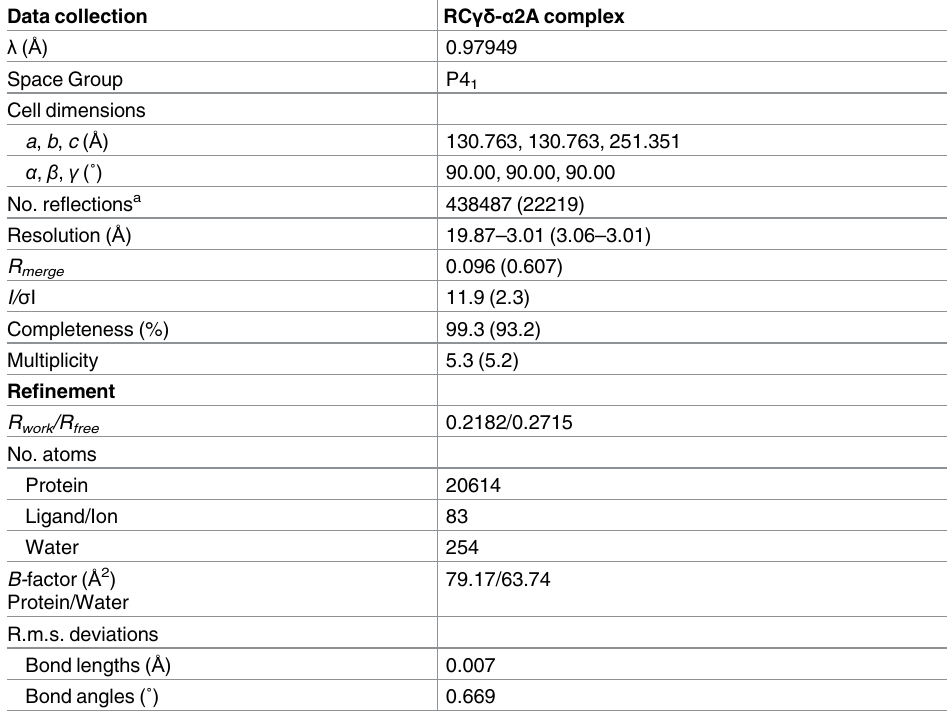
Table 1. Data and refinement statistics of the RC γδ - α 2Acrystal